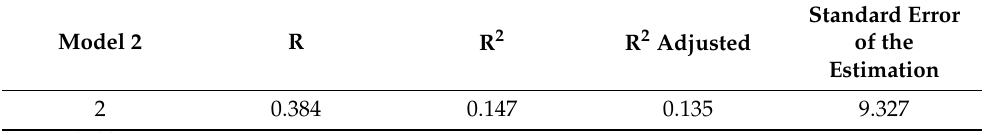
Table 6. Web of Science h-index Regression Statistics (Model 2).